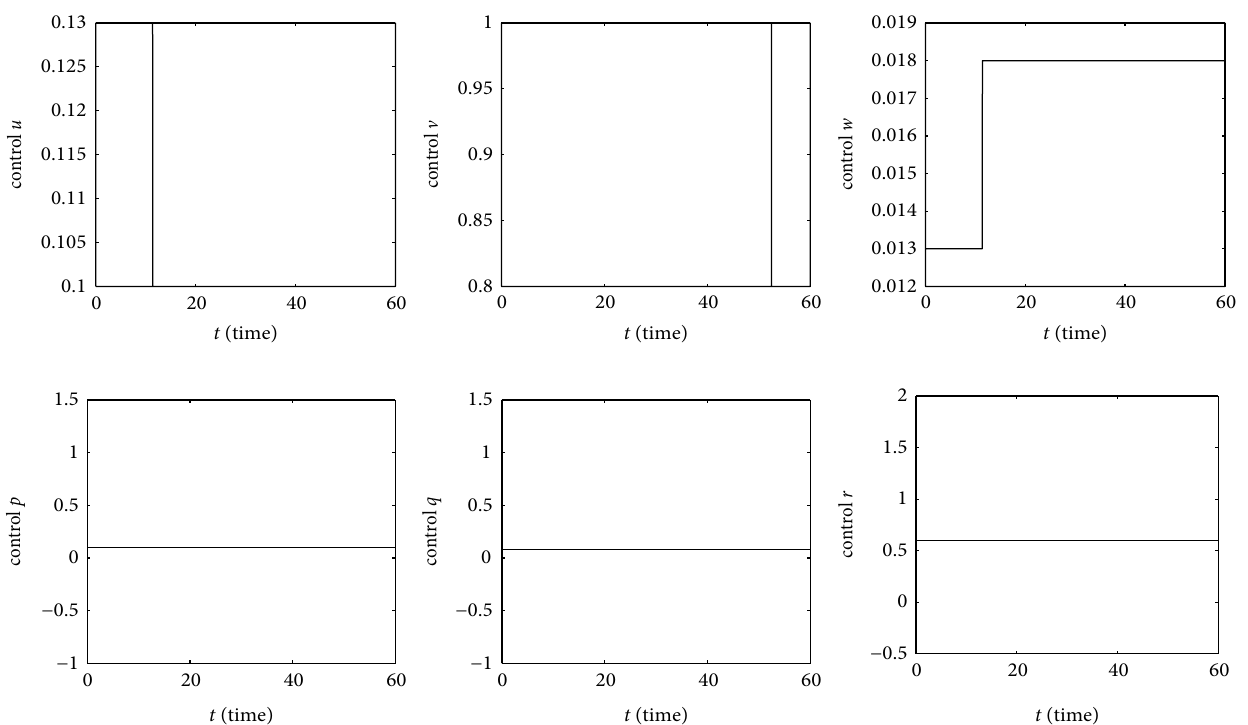
Figure 2: Optimal controls for 푇 = 60.0 : upper row: 푢